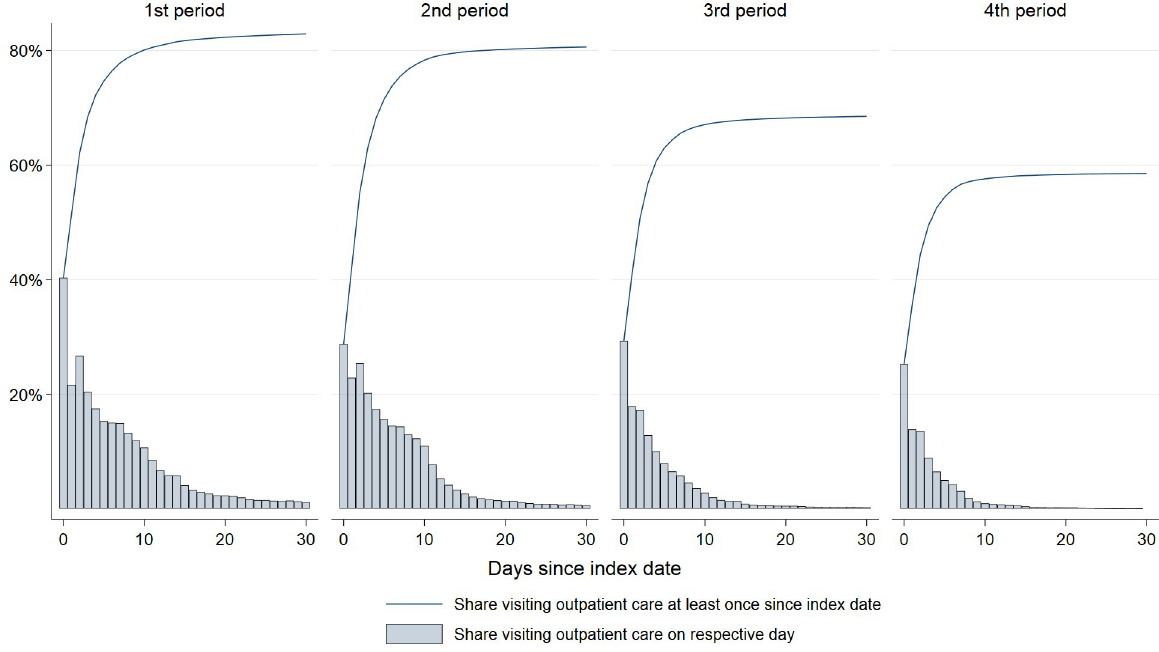
Fig 2. Shares visiting outpatient care. Day by day and cumulative shares seeking outpatient care (GP or emergency ward) from the day of testing positive (day 0) to the 30 th day after positive test, for four waves/periods of the pandemic: February 26 th , 2020 –February 16 th , 2021 (1 st period), February 17 th , 2021 –July 10 th , 2021 (2 nd period), July 11 th , 2021 –December 27 th , 2021 (3 rd period), and December 28 th , 2021 –January 14 th , 2022 (4 th